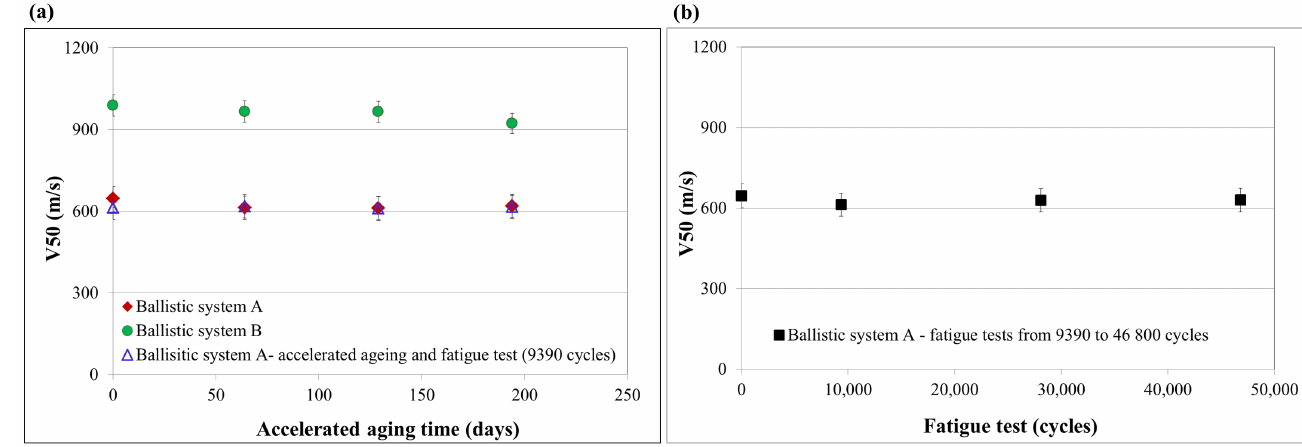
Figure 6. Fragment resistance of para-aramid inserts after accelerated aging cycles ( a ) and fatigue tests ( b ).